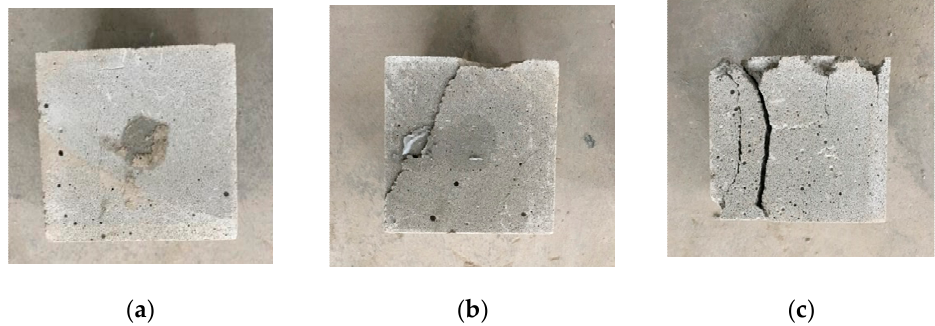
Figure 12. The failure mode of the foamed concrete at a density of 600 kg/m 3 . ( a ) 0.06 mm/min; ( b ) 0.60 mm/min; ( c ) 6 mm/min.